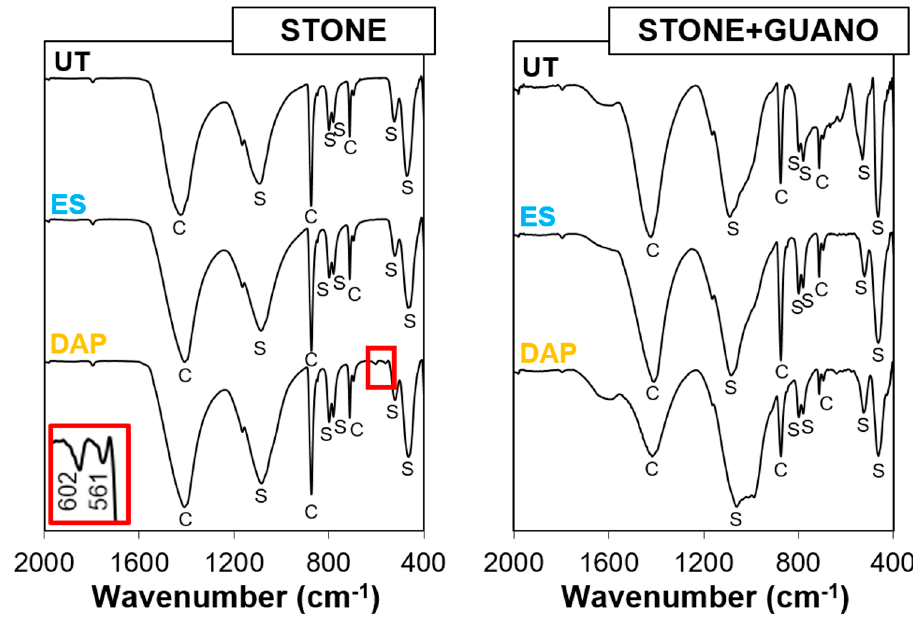
Figure 5. FT-IR spectra of untreated and treated stone (“ST”) and stone+guano (ST+G”) specimens. C = Calcite; S = Silica; new bands at 602 and 561 cm –1 , owing to the formation of new calcium phosphate phases, are highlighted in the inset.